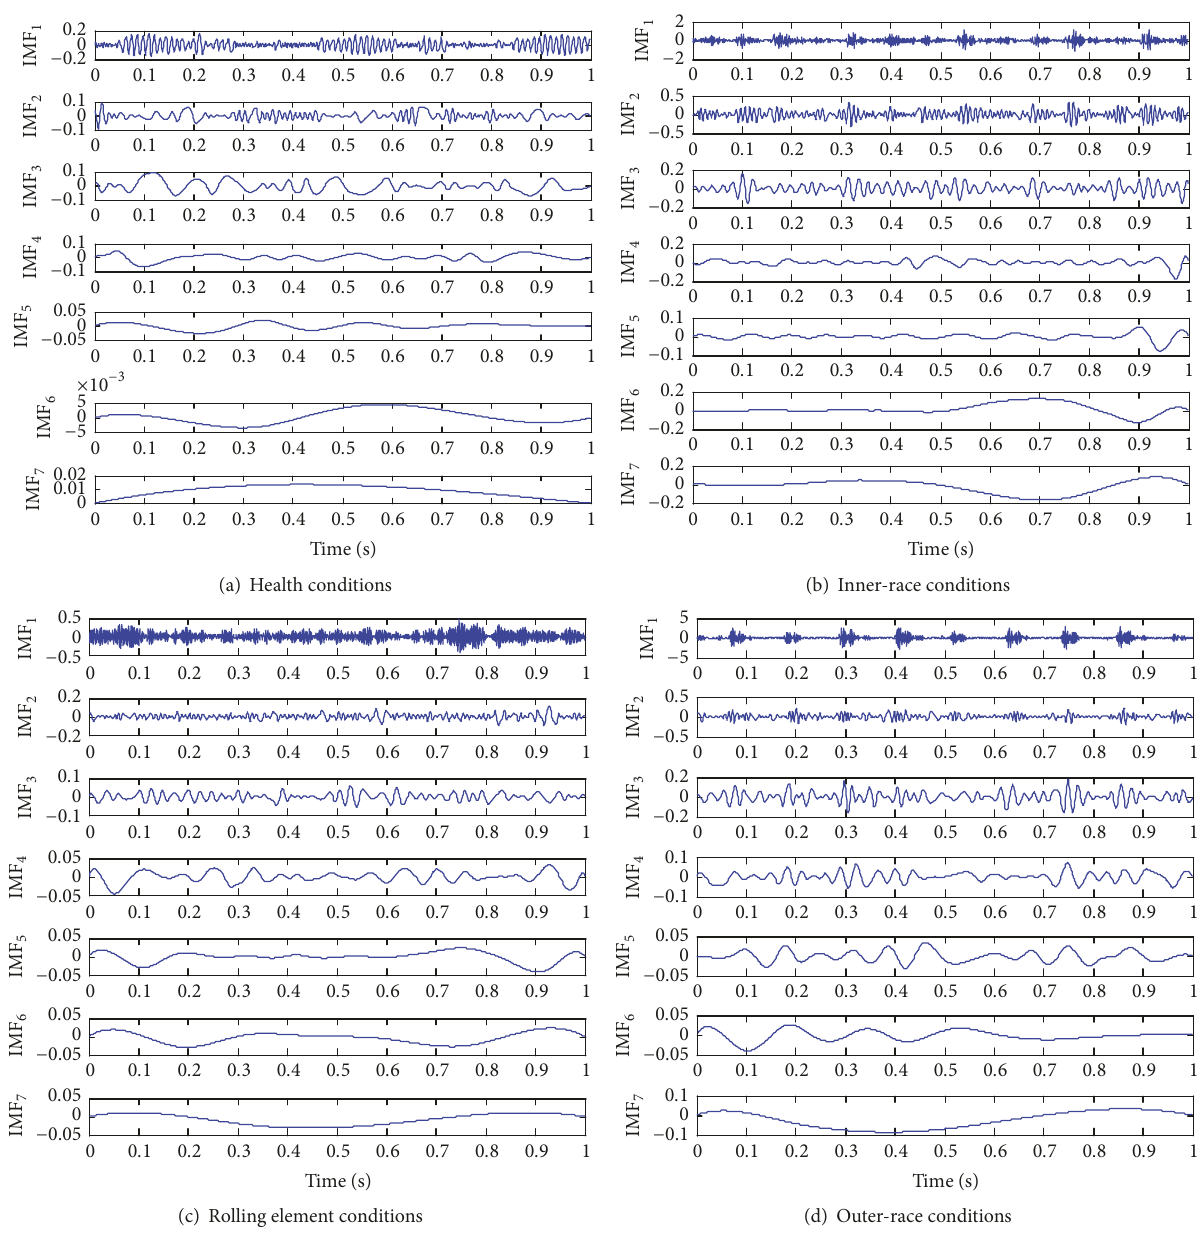
Figure 5: IMFs of four kinds of conditions in rolling bearing